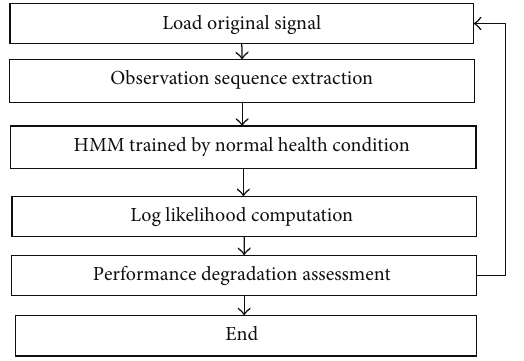
Figure 2: The presented flowchart for machine performance degra- dation assessment in the case of unavailable historical data.